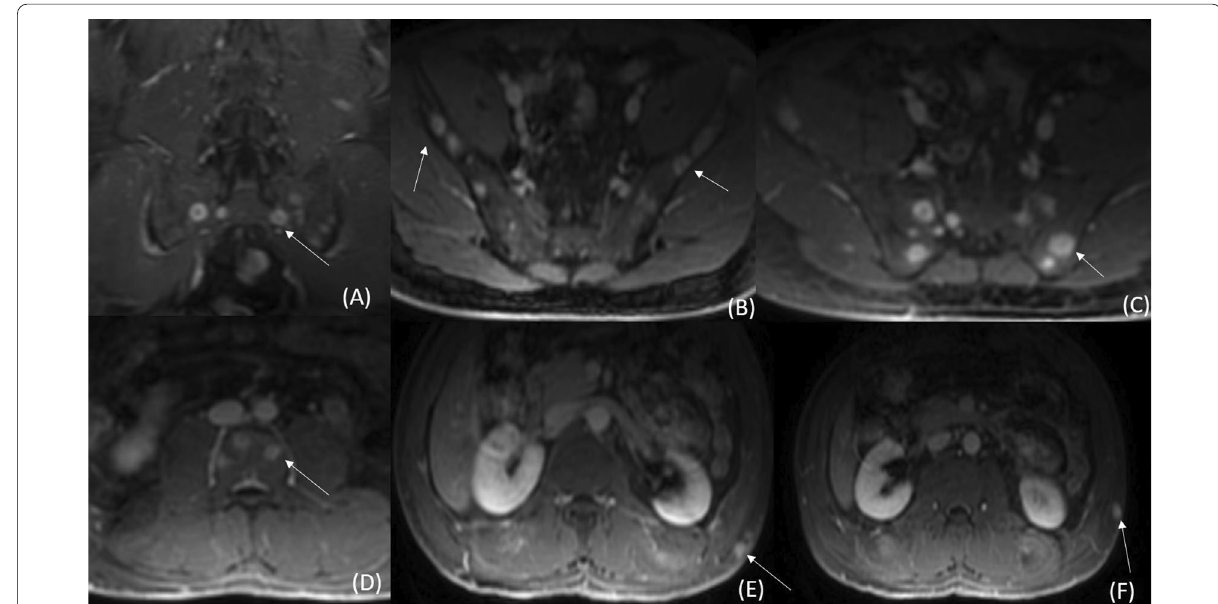
Fig. 9 Multifocal skeletal tuberculosis with subcutaneous tubercular deposits continued. T1 contrast-enhanced images of the same patient show multiple peripherally enhancing lesions (white arrows) in bilateral sacral ala ( A ), iliac blades ( B ), ischium ( C ) and lumbar vertebrae ( D ), homogeneously enhancing lesions are also seen in subcutaneous plane in left flank (white arrow in E and F )